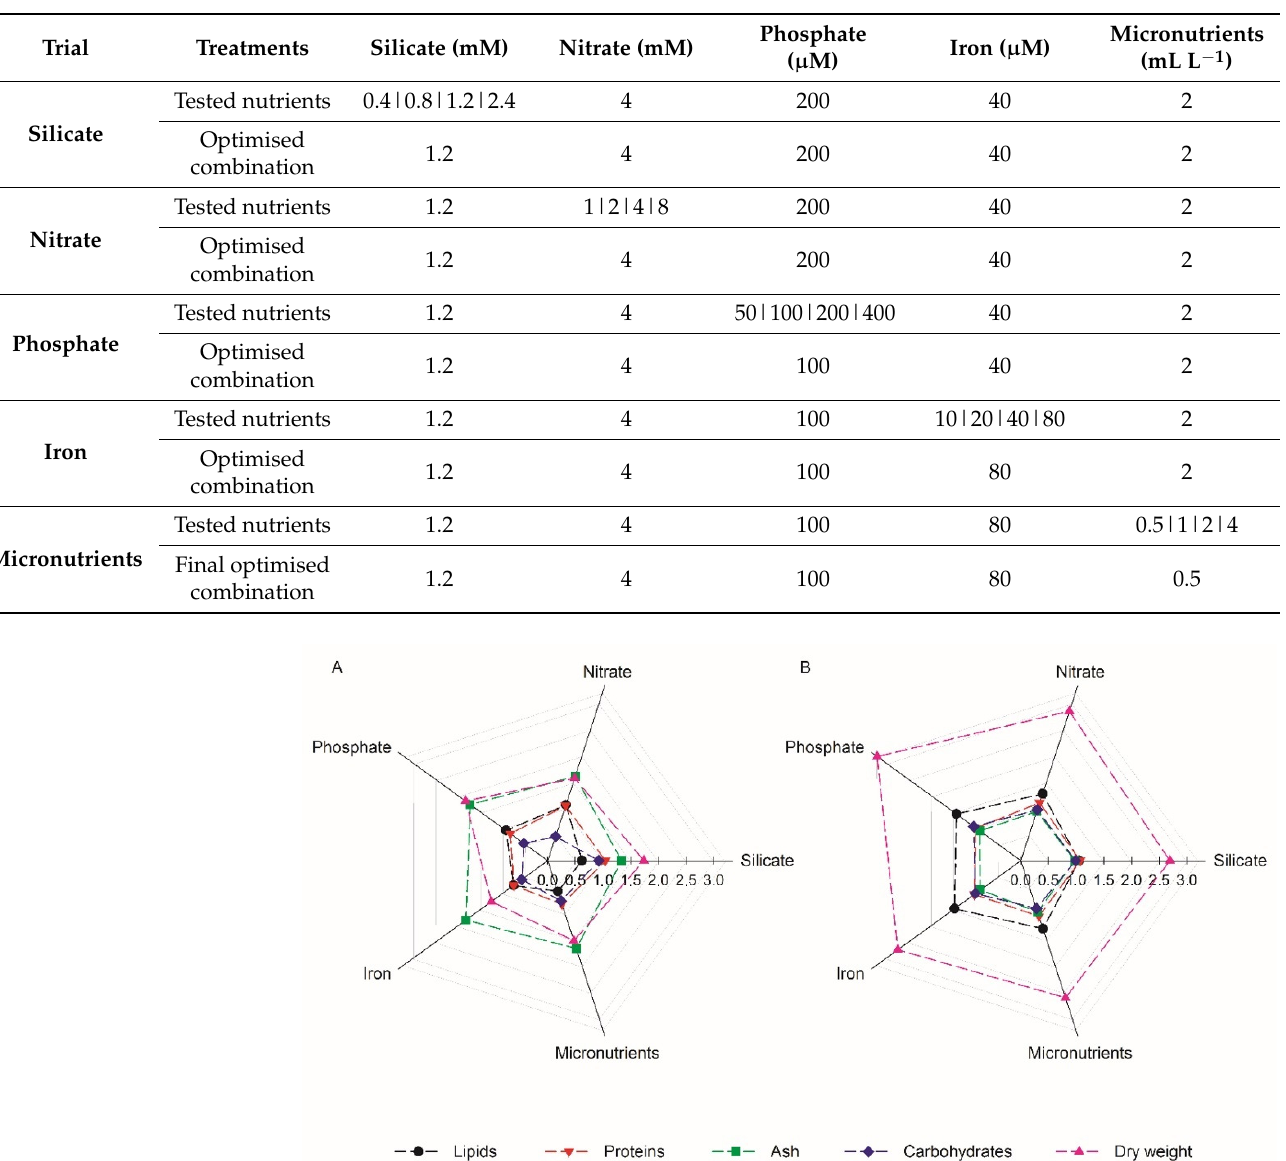
Table 3. Nutrient combinations as well the optimised concentrations that were obtained throughout the stepwise nutrient optimisation process of the C. calcitrans growth medium.